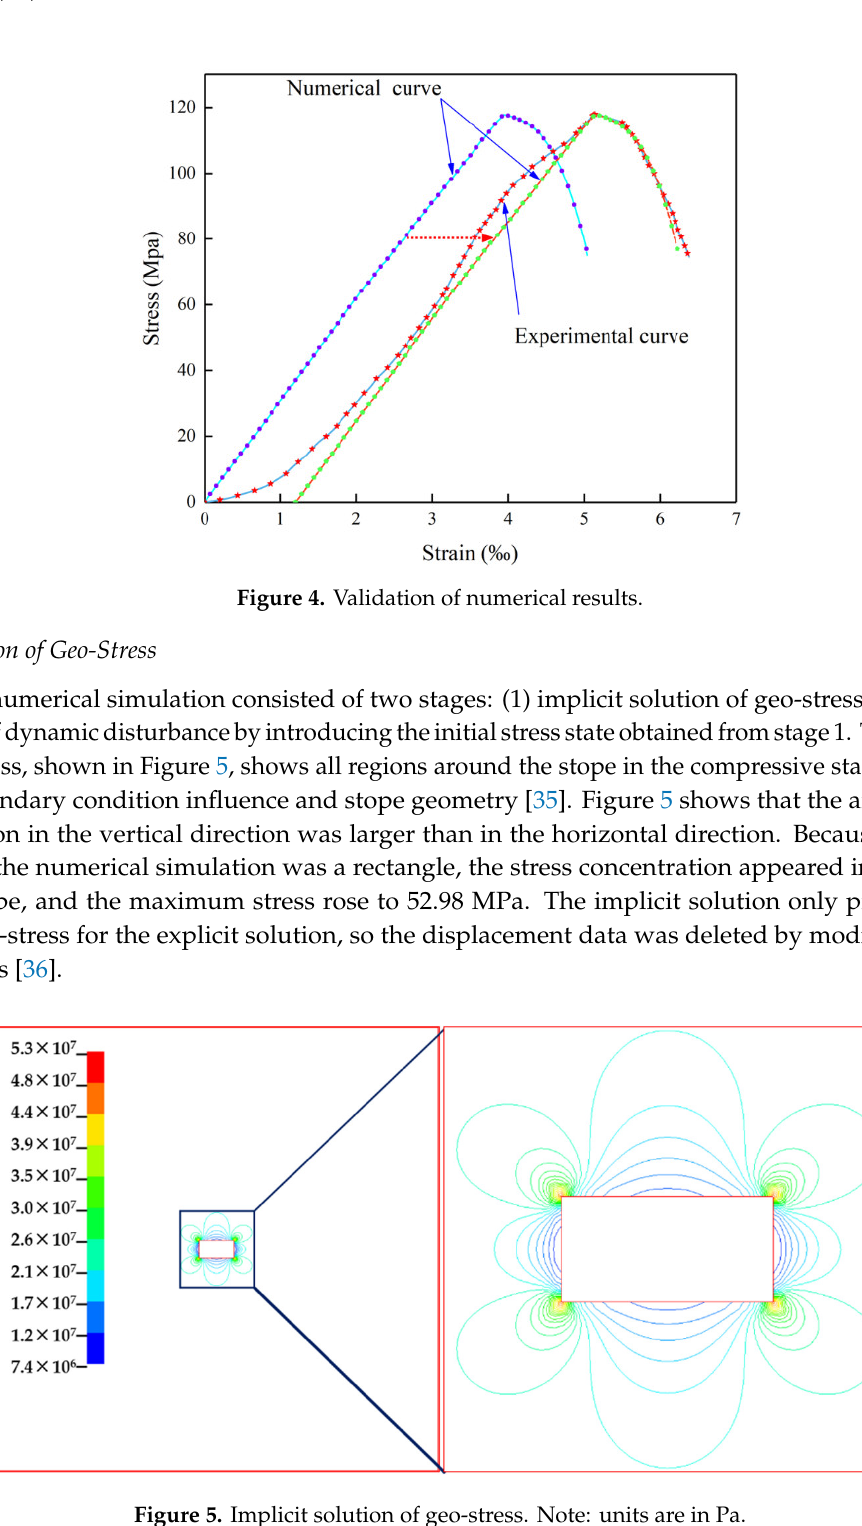
Figure 5. Implicit solution of geo-stress. Note: units are in Pa.